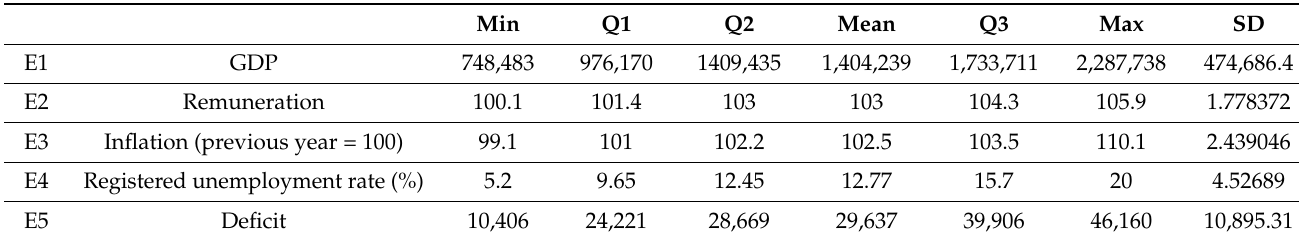
Table 3. Basic descriptive statistics of variables used to create economic KPIs. Min